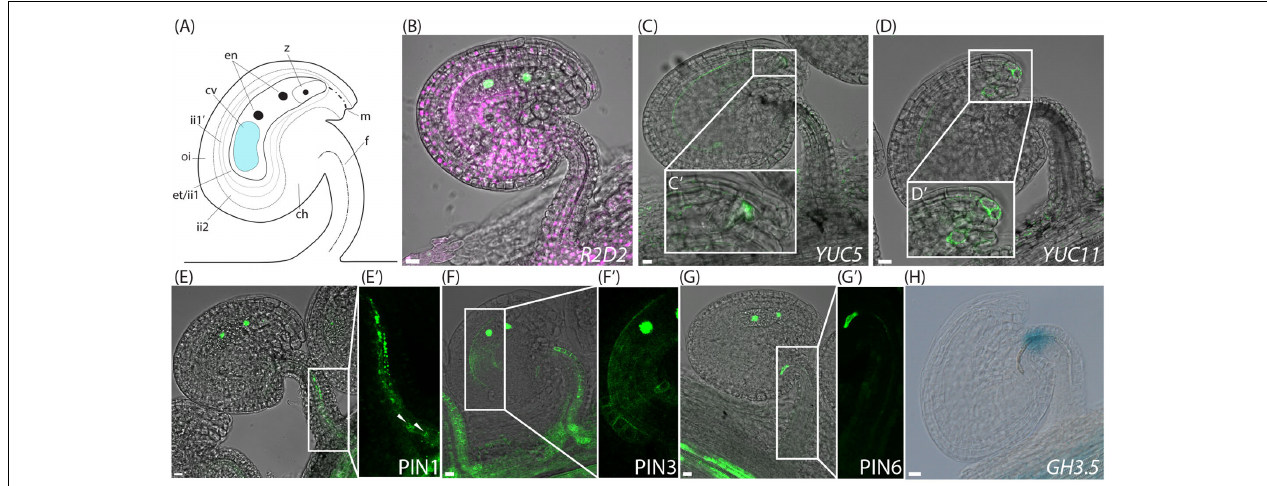
FIGURE 4 | Auxin sensing, biosynthesis, transport and conjugation in ovules post-fertilization. (A) Schematic overview of an ovule after the first nuclear division of the central cell shortly after fertilization, ch, chalazal domain; cv, central vacuole; en, endosperm nuclei; et, endothelium; f, funiculus; ii, inner integuments; m, micropylar end; oi, outer integuments; z; zygote. (B,G) Merged confocal and transmitted light images of R2D2 activity (B) , YUC5pro:3xGFP expression in the developing endosperm and in the micropylar end of the inner integument tip cells (C,C (cid:48) ) , YUC11pro:3xGFP expression in the micropylar end of the inner integuments (D,D (cid:48) ) , PIN1pro:PIN1-GFP expression in the funiculus (E,E (cid:48) ) , PIN3pro:PIN3-GFP expression in the funiculus and in the inner integuments (F,F (cid:48) ) , PIN6pro:PIN6-GFP expression (G,G (cid:48) ) in ovules at the two nucleate endosperm stage post-fertilization. (H) DIC image of a GUS stained GH3.5pro:GUS ovule at the two nucleate endosperm stage post-fertilization showing GH3.5 expression in the upper part of the funiculus. (C (cid:48) –G (cid:48) ) Show higher magnifications of the boxed areas in (C–G) , respectively. Arrowheads in (E (cid:48) ) indicate basal PIN1 localization. Bars = 10 µ m. All images are representatives of at least 10 independent samples.